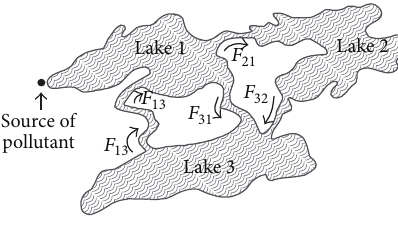
Figure 1: Three lakes system with interconnecting